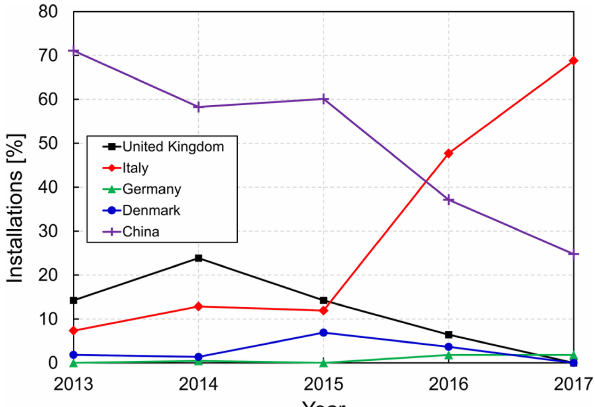
Figure 2. Evolution of the country’s share in the newly installed SWT capacity for that year for a number of key European countries and China. Data from Orrell et al.